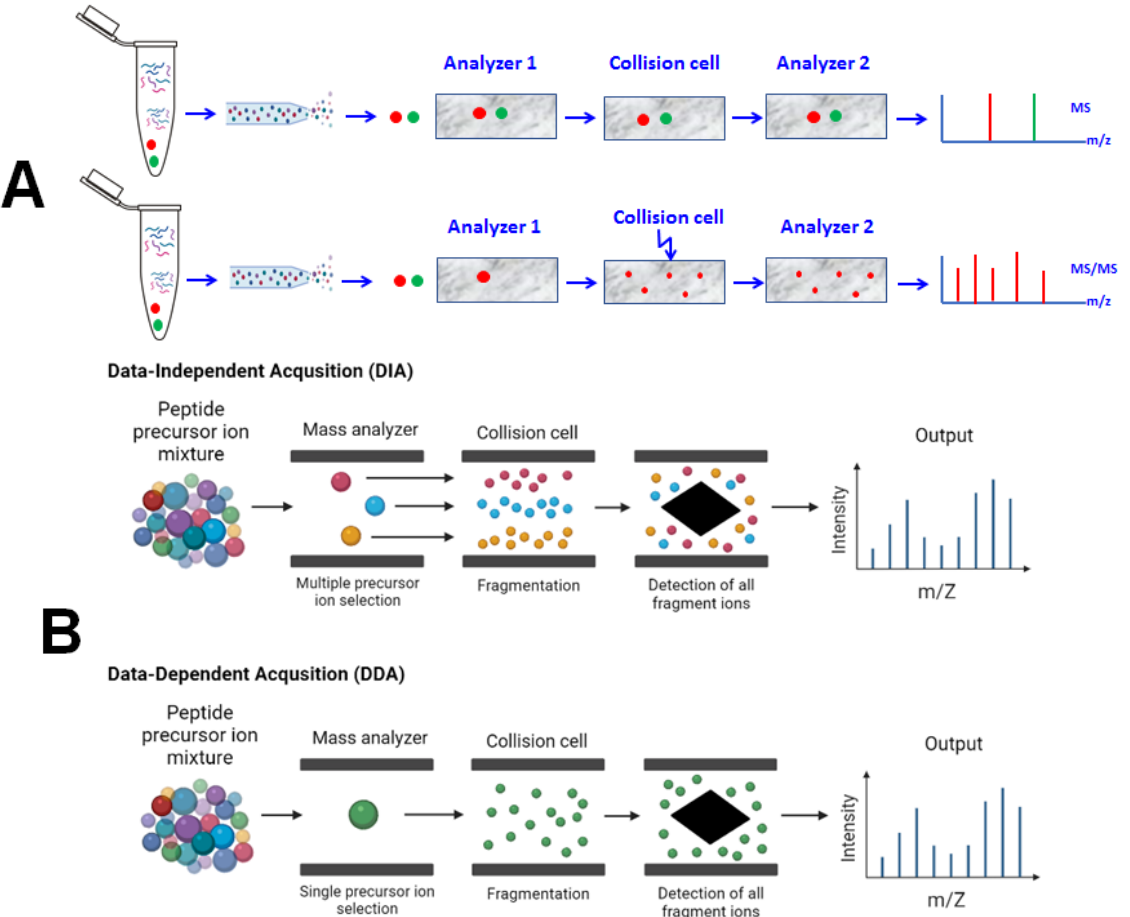
Figure 1. ( A ) Overview of analysis by Tandem Mass Spectrometry. The digested peptides are ionized and passed through the first mass analyzer; analyzed in the second analyzer; and detected as MS spectra, survey spectra, or MS1. The high-intensity peaks from the resulting spectra (MS1) are further selected in the first mass analyzer, fragmented in the collision cell, and then analyzed in the second mass analyzer, resulting in the product ions, detected in MS/MS spectra (MS2), which contain the information for peptide sequencing followed by protein identification. ( B ) Overview of the different modes of data collection in tandem mass spectrometry. In DIA, all precursor ions are analyzed simultaneously and in MS mode (i.e., with low-collision energy) and then fragmented in the collision cell using high-collision energy. Multiple product ions that resulted from the fragmentation of multiple precursor ions are then detected in one spectrum. In DDA, all precursor ions are detected in the survey MS spectrum, and then, the precursor ions that have the highest intensity are selected in the first analyzer (i.e., quadrupole), fragmented in the collision cell, analyzed in the second analyzer (i.e., TOF), and detected as the MS/MS